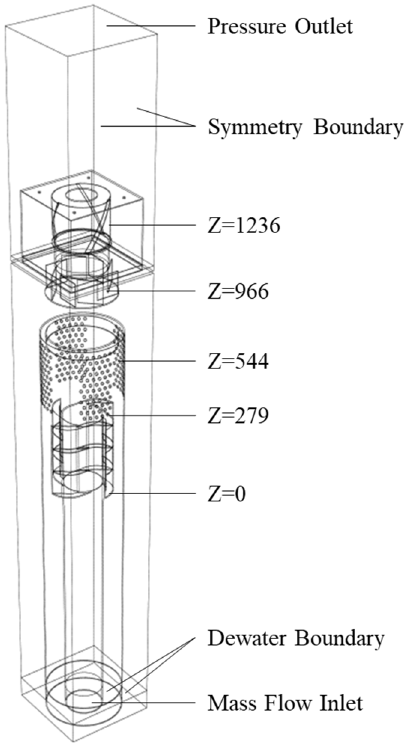
Figure 2. Calculation zone and boundary conditions.